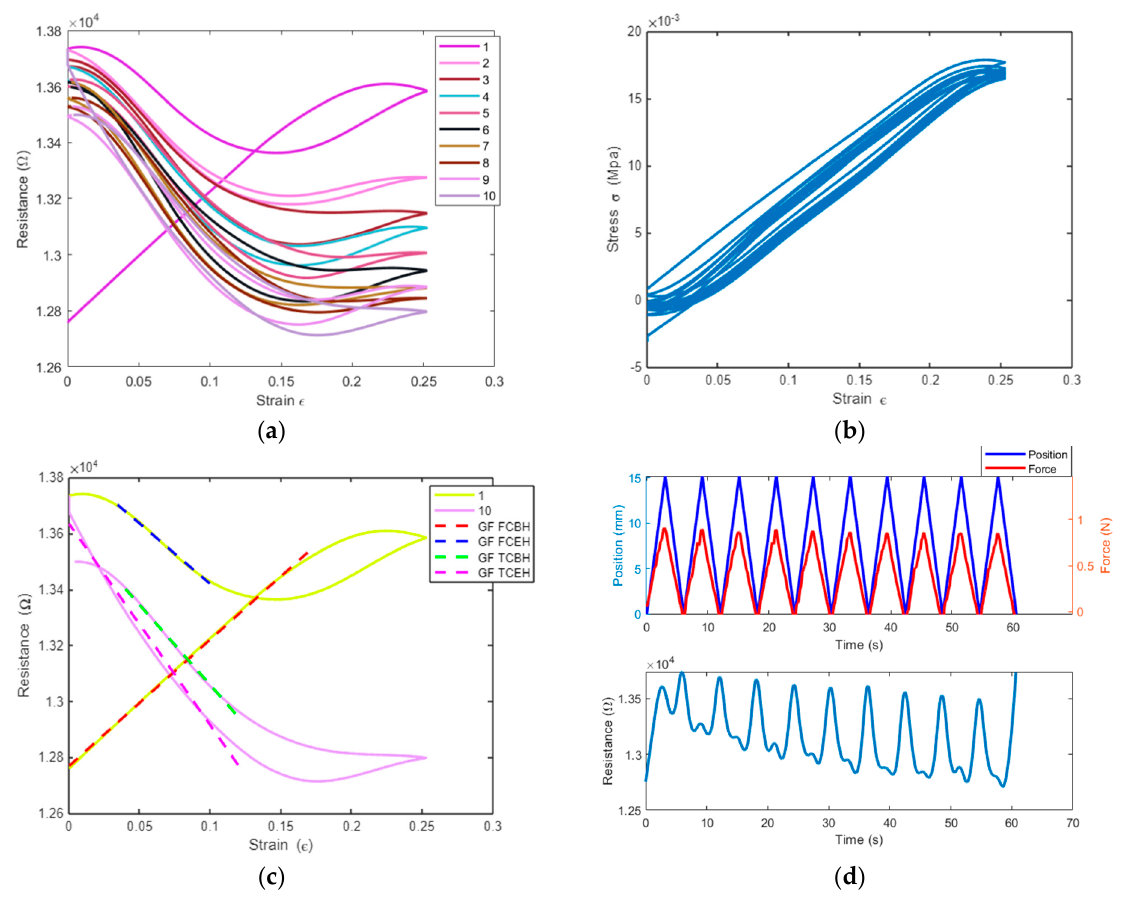
Figure 13. RCSS cyclic tensile test results: (a) Resistance vs. strain for ten cycles. (b) Stress vs. strain for ten cycles. (c) Resistance vs. strain and gauge factors for the first and the tenth cycles. (d) Displacement, force, and resistance change over time for ten cycles.